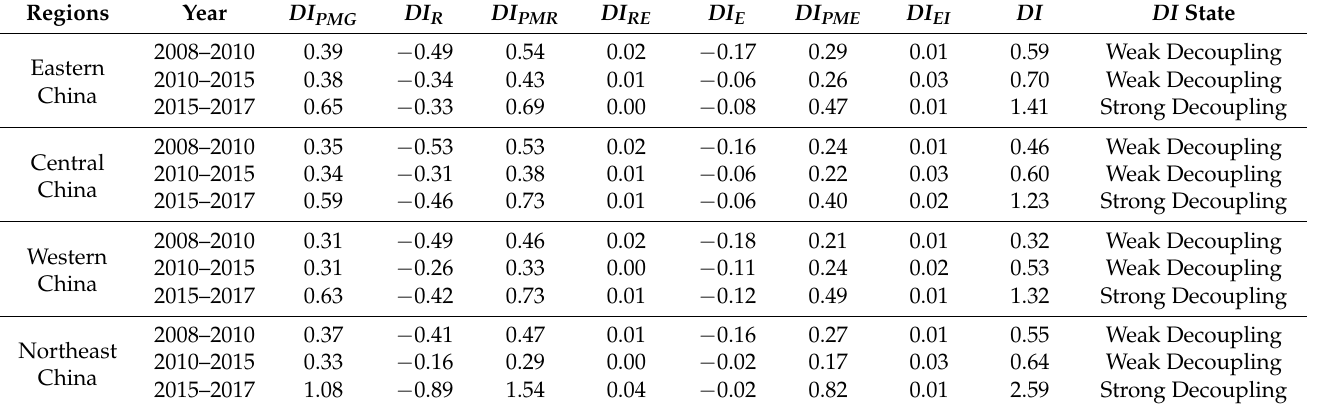
Table 3. The roles of different drivers in decoupling across China’s four subregions from 2008 to